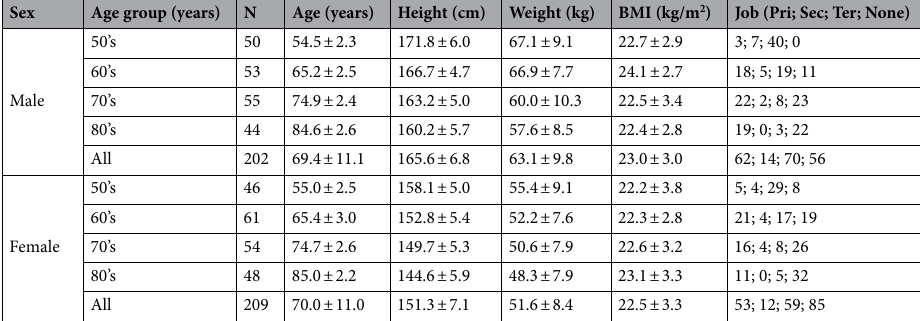
Table 4. Characteristics of the study cohort. Values represent the mean ± standard deviation. BMI body mass index, Pri primary sector, Sec secondary sector, Ter tertiary sector.